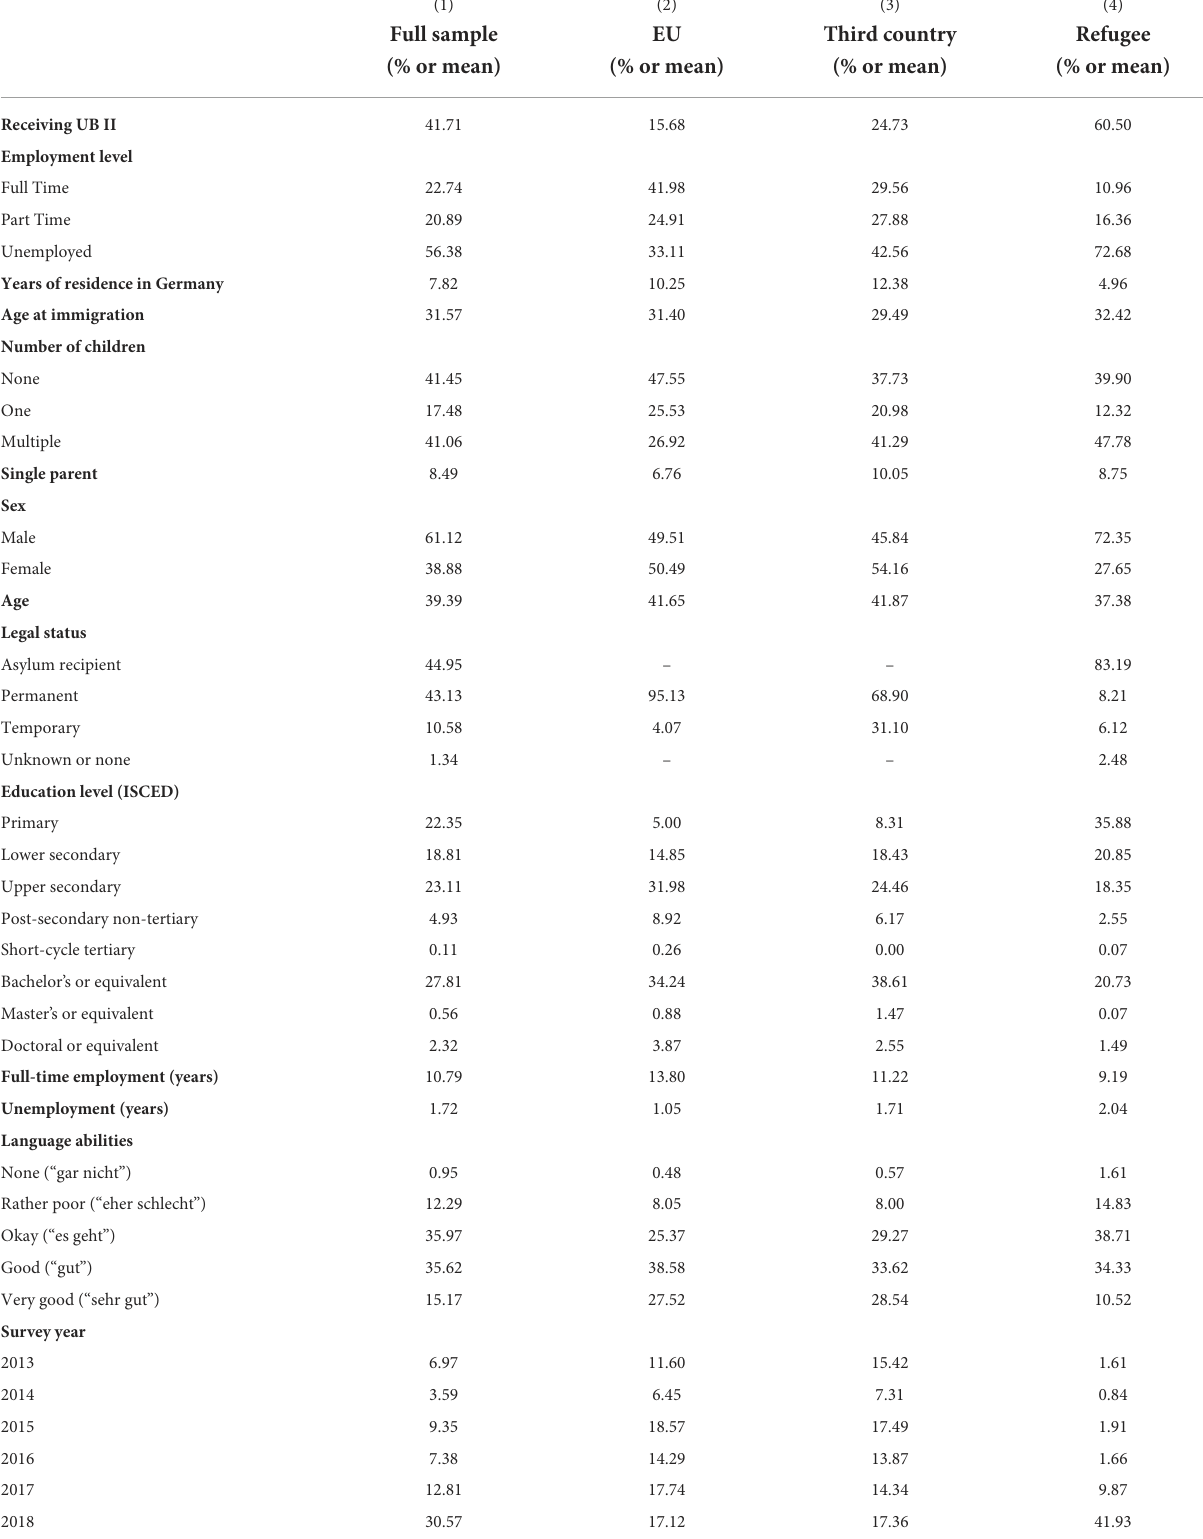
TABLE 1 Descriptive statistics of variables for full sample and immigrant